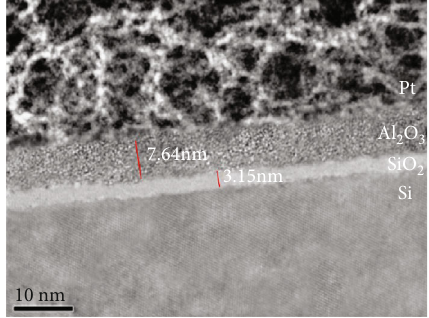
Figure 3: TEM picture of Al oxide was annealed at 600 ° C for 90 seconds.